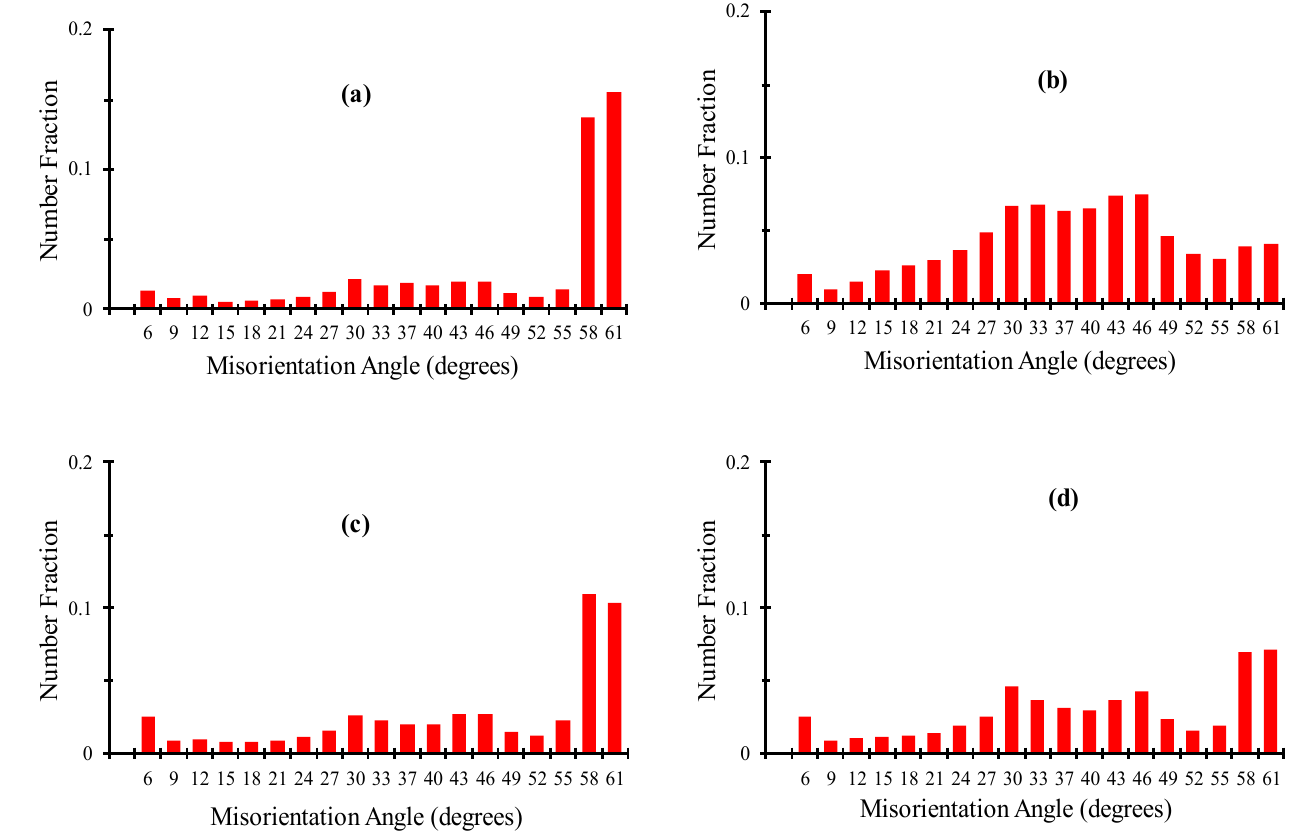
Figure 10. Misorientation angle distributions of ( a ) flat-built (XZ plane), ( b ) flat-built (XY plane), ( c ) side-built (XZ plane), and ( d ) top-built (XZ plane).